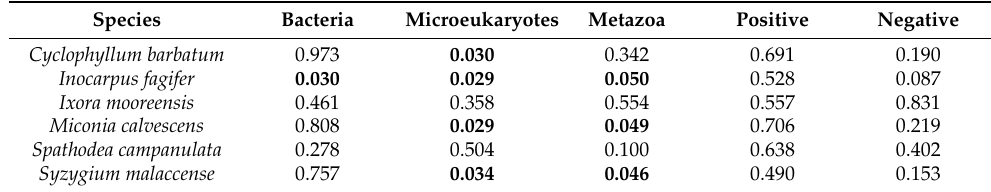
Table 1. Developmental e ff ects on soil diversity. p values are indicated based on a PERMANOVA. Signi fi cant p values are in bold.